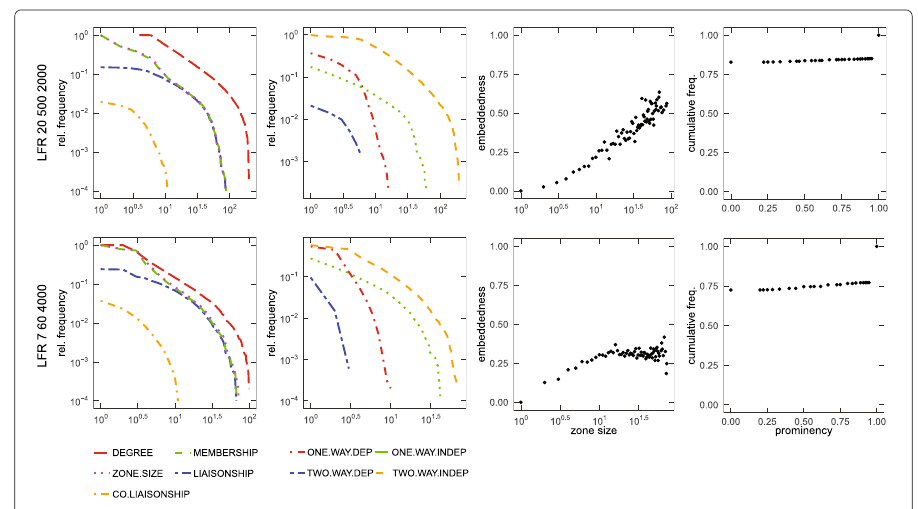
Fig. 13 Properties of LFR networks. The two LFR networks have similar characteristics to the biological networks. However, they have higher average embeddedness, which is mainly due to the higher embeddedness of larger zones with more than ten nodes Zone overlaps and their